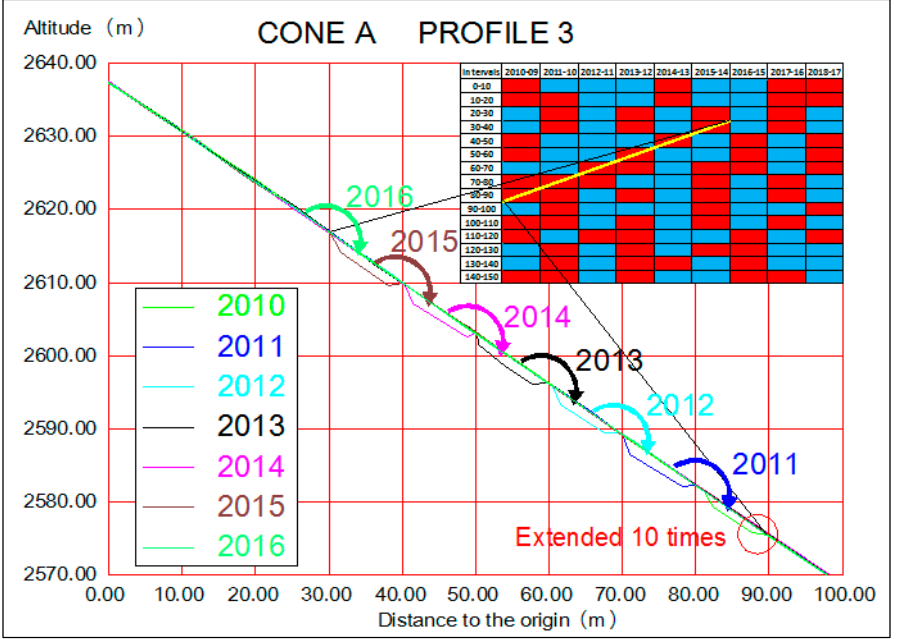
Figure 15. Profile indicating retreating thinning throughout a period of 6 years (2010–15). The effects of the retreat of the profile have been amplified x 10.